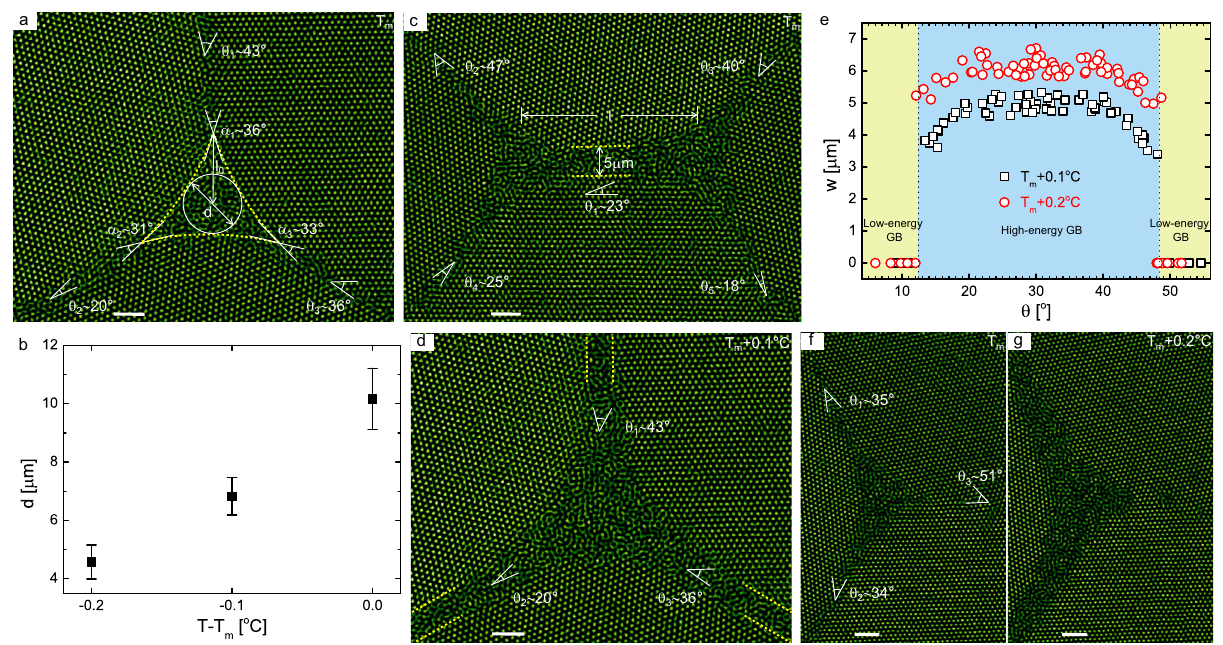
Fig. 2 Premelting at triple junctions. a Real image of a typical premelted triple junction at the melting point. l 0 is the distance between the centre of the inner tangent circle of the premelted pocket and a crystal – crystal – liquid triple junction. b The size of the premelted pocket d increases as T approaches T m . c Two close triple junctions help wet the GB in between and cause pseudo “ premelting ” . d The GBs melt into liquid layers via intrusion once T > T m . e The equilibrium widths of the melted GBs w as a function of misorientation θ at T m + 0.1(2) °C. The inclination angles are arbitrarily chosen under each θ . f , g Melting behaviour in the case of a low-angle GB connected to the triple junction. It is noteworthy that both uniform and local heating methods yield the same a – g , which means that the glass walls in our system have a minor effect on melting behaviour of triple junctions. Since the cross-section of the liquid region is uniform along the z direction, we fi xed the object plane in the middle range of the glass channel. Error bars correspond to the standard deviation. Scale bars: 5 μ